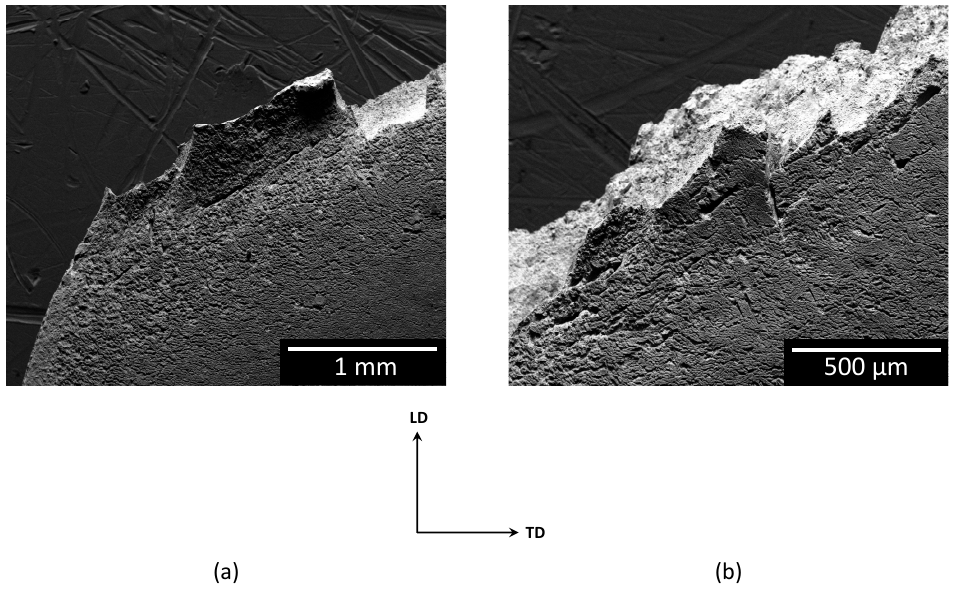
Figure 9. Representative secondary electron images of the top surface for non-coated NiCrMoV steel tested in 0.01 M acetic acid at 90 °C ( a ) corrosion damage on the entire surface is visible with more damage close to the main crack, ( b ) detail of the small cracks close to the main crack [61]. Adapted from [61], with permission from Elsevier, 2020.